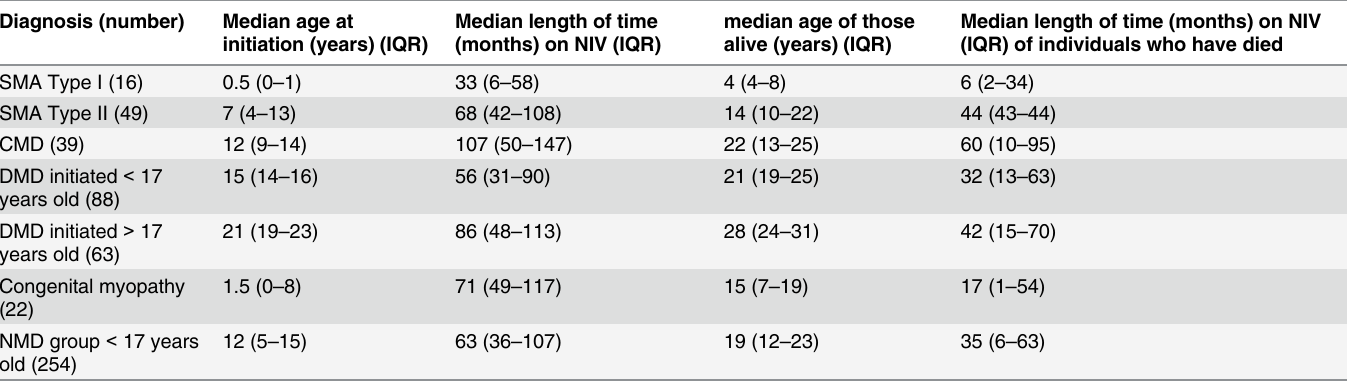
Table 4. Age and length of time of ventilatory support by neuromuscular diagnoses. Diagnosis